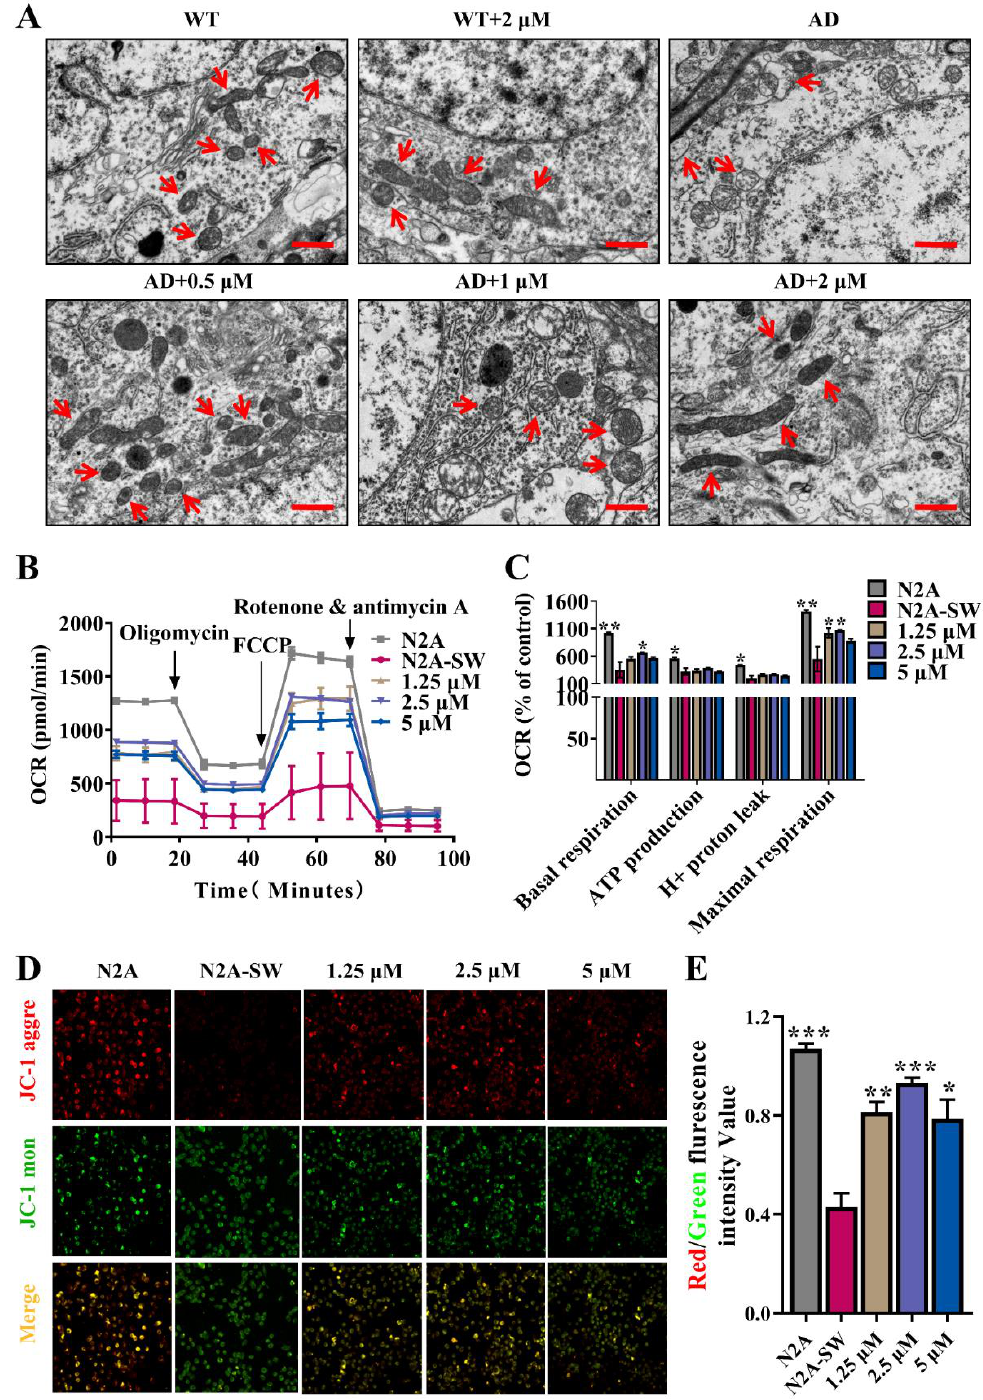
Figure 5. Effect of Ebselen on mitochondrial state: ( A ) Transmission electron microscopic images of mitochondria (red arrows) in the cerebral cortex of mice (scale bar: 10 µ m; n = 3). ( B , C ) Mitochondrial respiration of N2a-SW cells, including the real-time change of OCR levels in cells, ( B ) and key parameters of mitochondrial function obtained from the OCR curve involving basal respiration, ATP production, H + protein leak and maximal respiration ( C ). ( D , E ) Cellular ΔΨm measured by a JC-1 fluorescent probe, including representative images of cells stained with JC-1 ( D ), and red/green fluorescence intensity ( E ). (* p < 0.05, ** p < 0.01, *** p < 0.001 vs. AD group; n = 4).